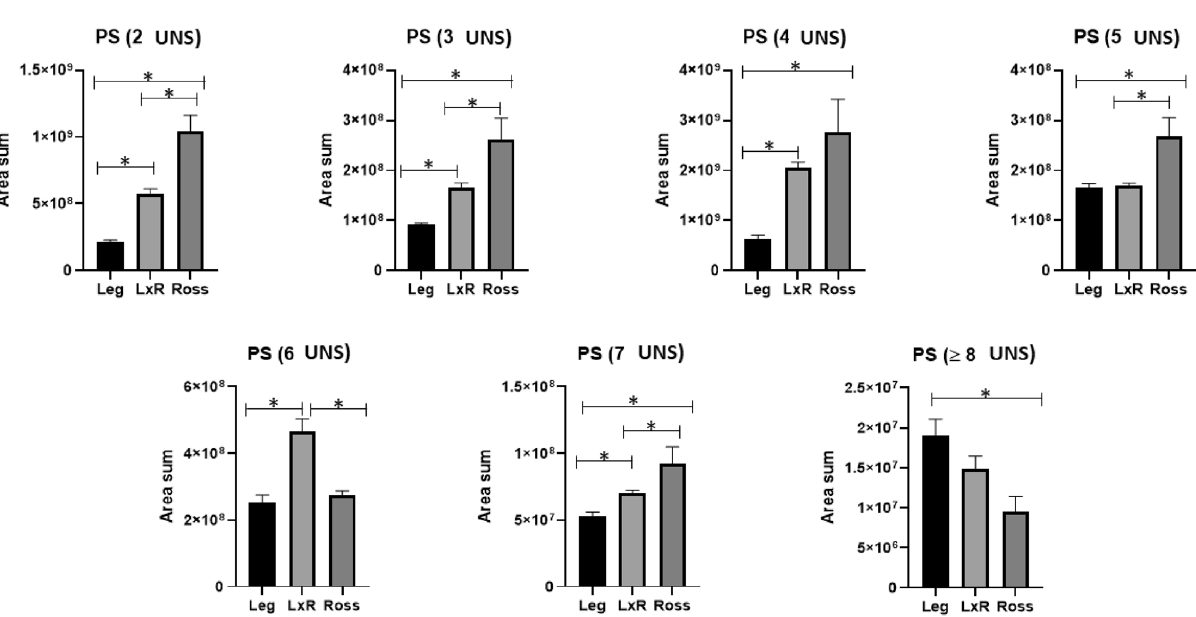
Figure 6. Phosphatidylserine (PS) with different unsaturation levels (from 2 to ≥ 8 UNS). Leg: Leghorn genotype; LxR: crossbreed, Ross: Ross 208 genotype. *P < 0.05 (post hoc Tukey’s